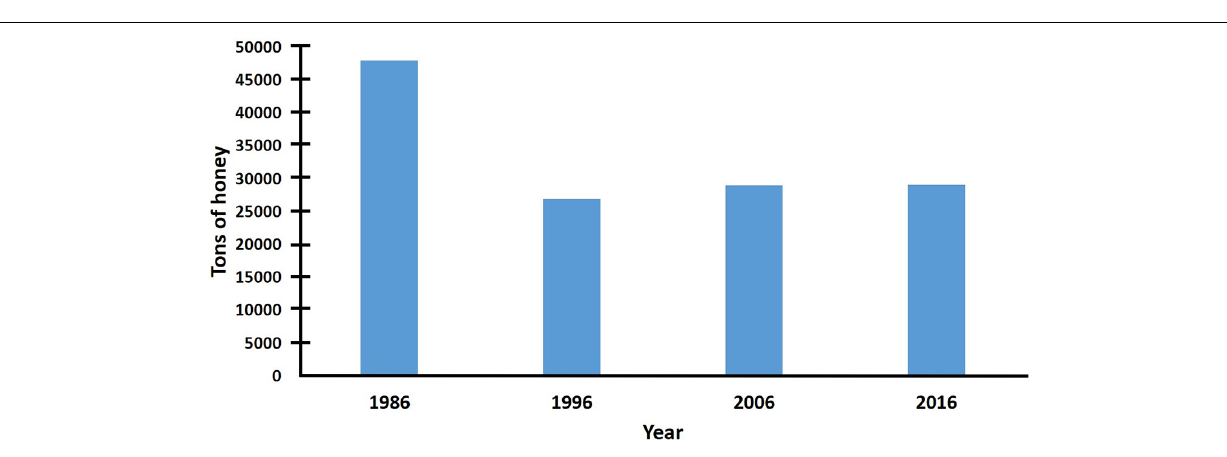
Frontiers in Ecology and Evolution |